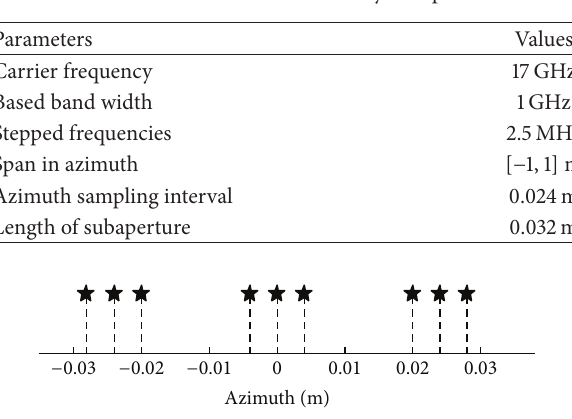
Table 2: Ground-based DPCA SAR system parameters.